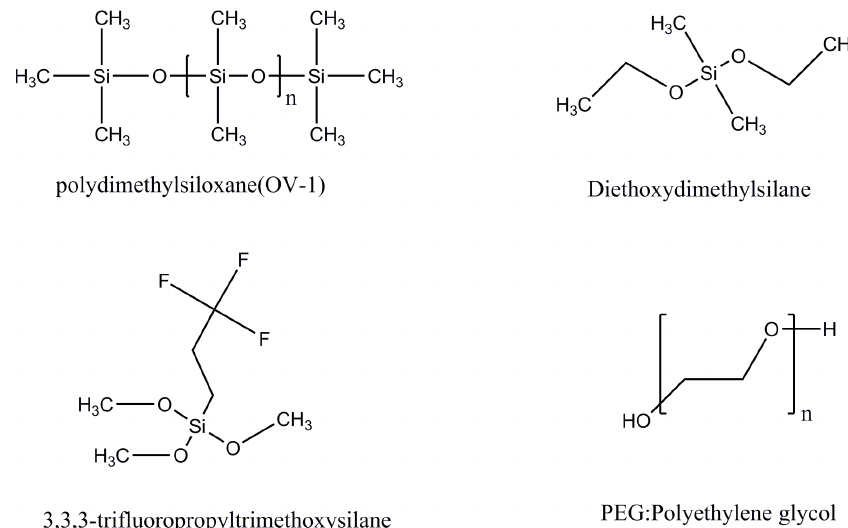
Figure 3: structures of some polymeric stationary phase